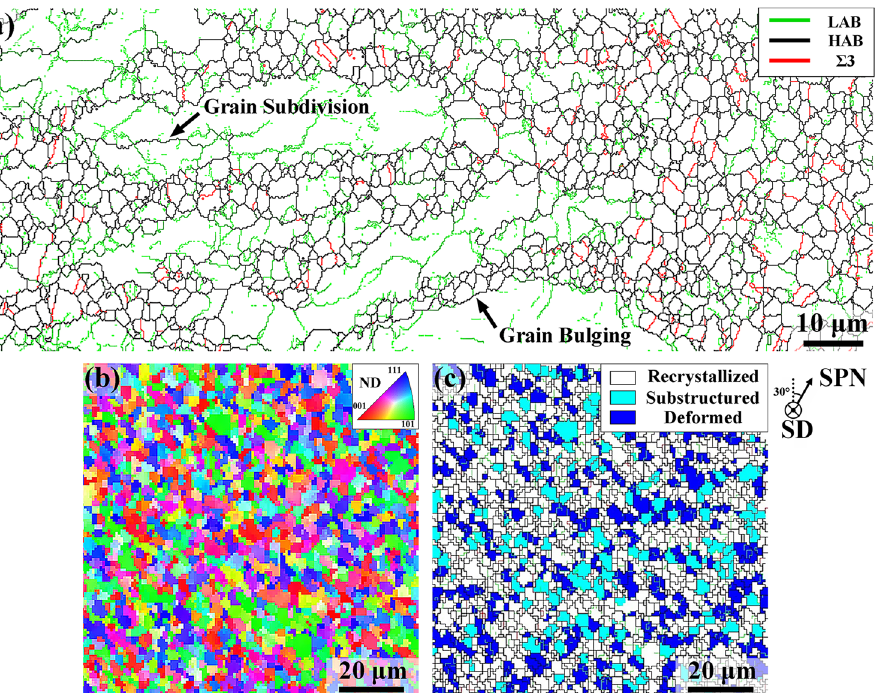
Figure 12: ( a ) Special boundary map at the edge of the stir zone on the retreating side, ( b ) inverse pole figure, and ( c ) misorientation map in the SZ. In ( a and c ) , the LAB, HAB, and Σ 3 boundaries are depicted as green, black, and red lines, respectively. For ( c ) , the colors navy blue, light blue, and white represent deformed, substructured, and recrystallized grains, respectively. The shear plane normal ( SPN ) and the shear direction ( SD ) of the three figures are as